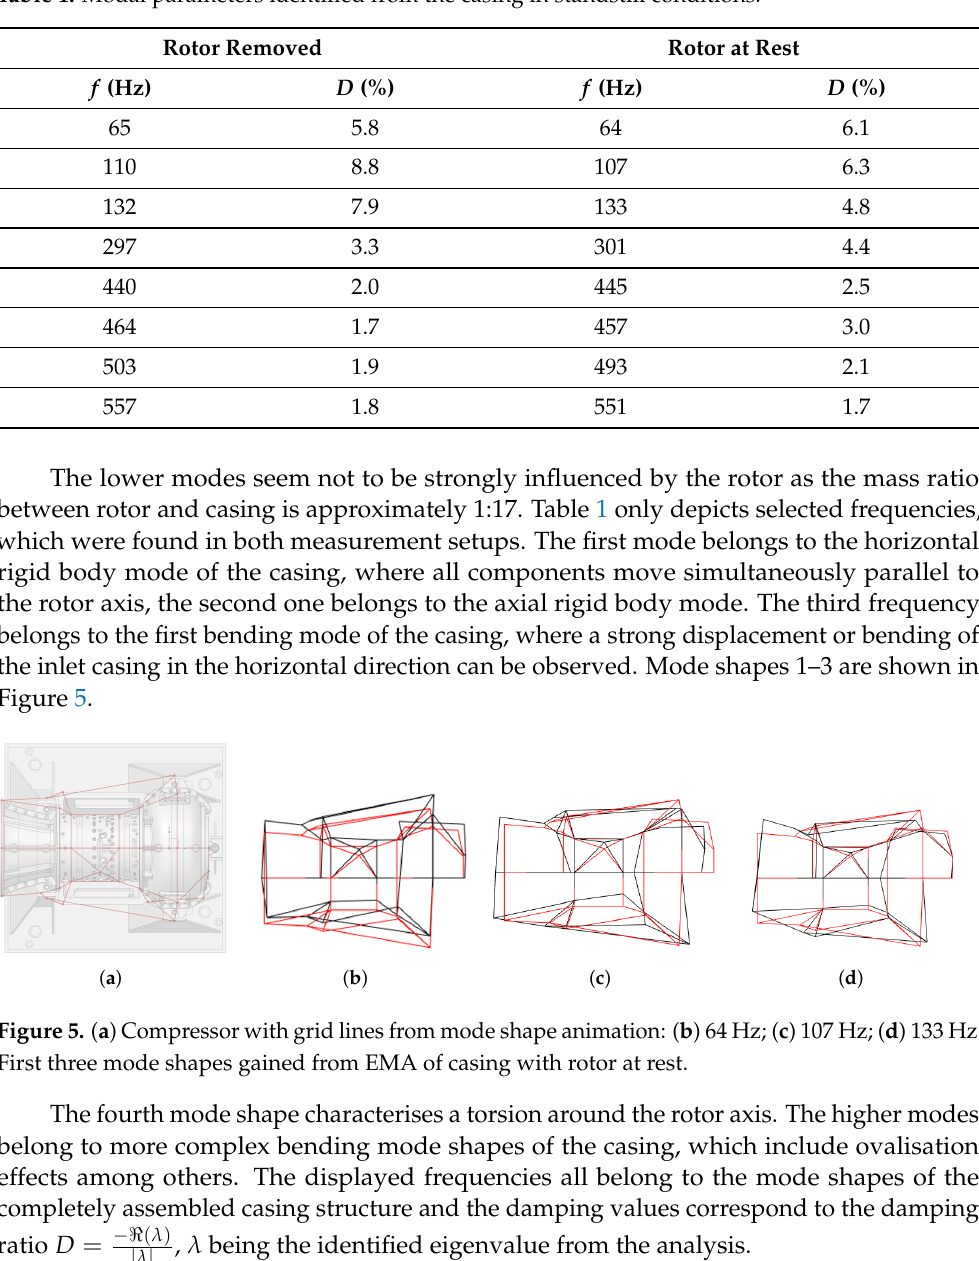
Table 1. Modal parameters identified from the casing in standstill conditions.